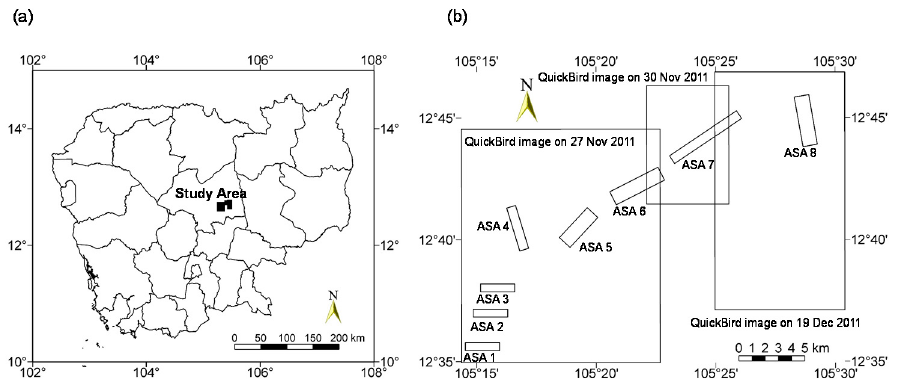
Figure 1. Cont. Figure 1.